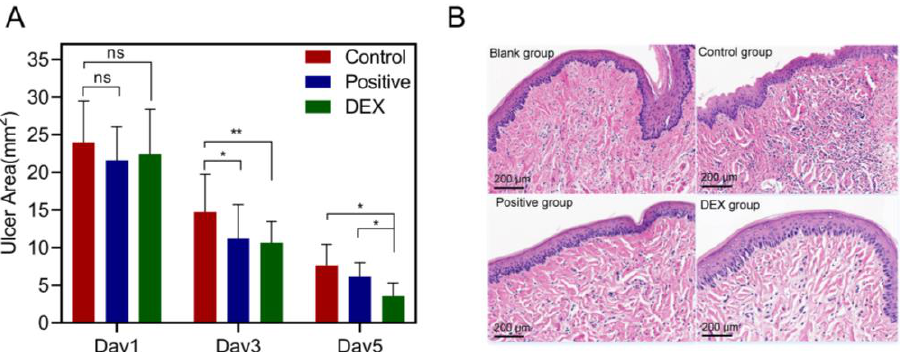
Figure 13. ( A ) Ulcer area changes of the model, positive and DEX groups after treatments (n = 4, * p < 0.05, ** p < 0.01, ns: no significant difference); ( B ) HE staining results of different groups after treatments.